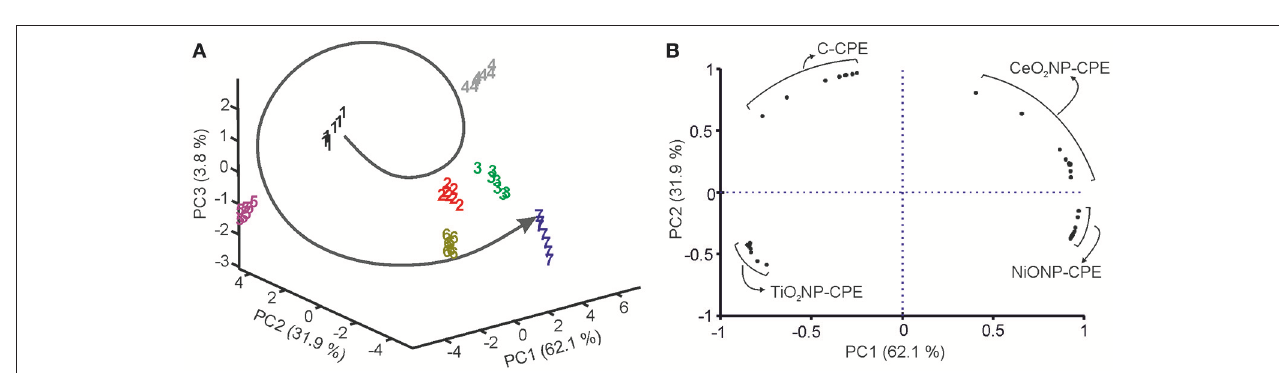
FIGURE 7 | (A) 3D Score plot, (B) Loading plot of PCA performed from grape juices from the variety Juan Garcia harvested weekly from véraison to over-ripening (1: First week, 2: Second week, etc. 7: Over-ripening week).